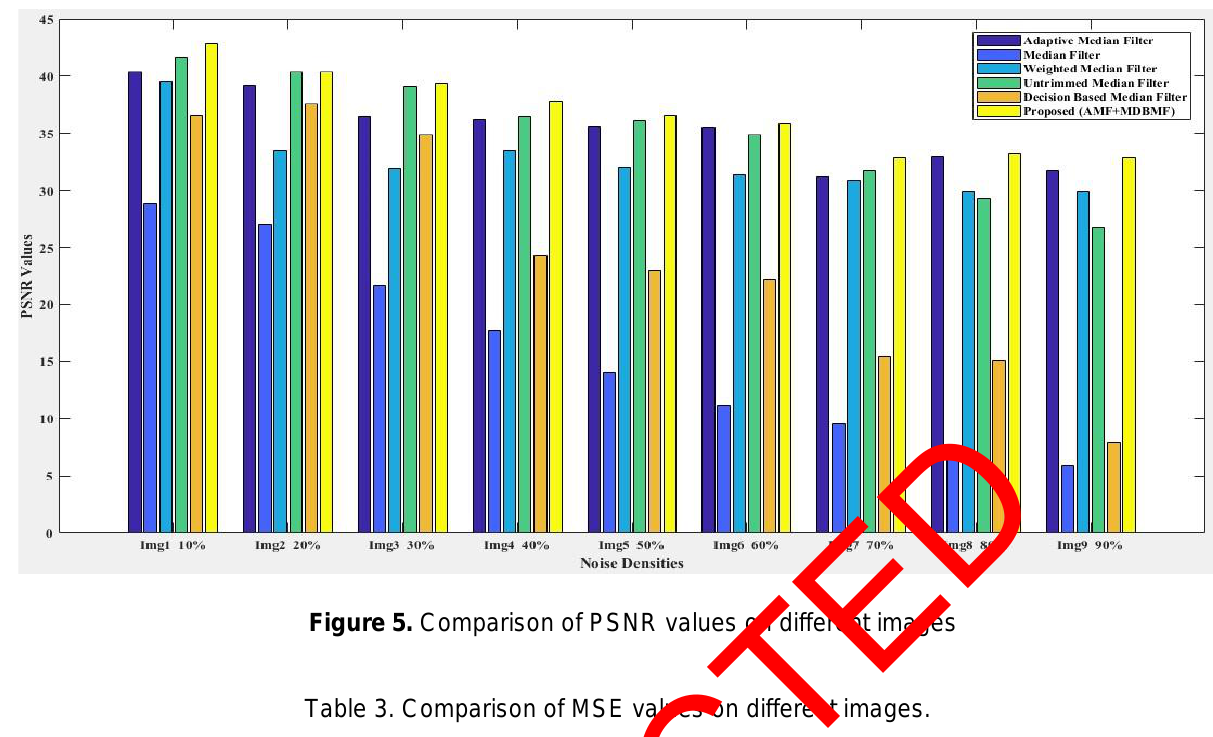
Figure 5. Comparison of PSNR values on different images Table 3. Comparison of MSE values on different images.